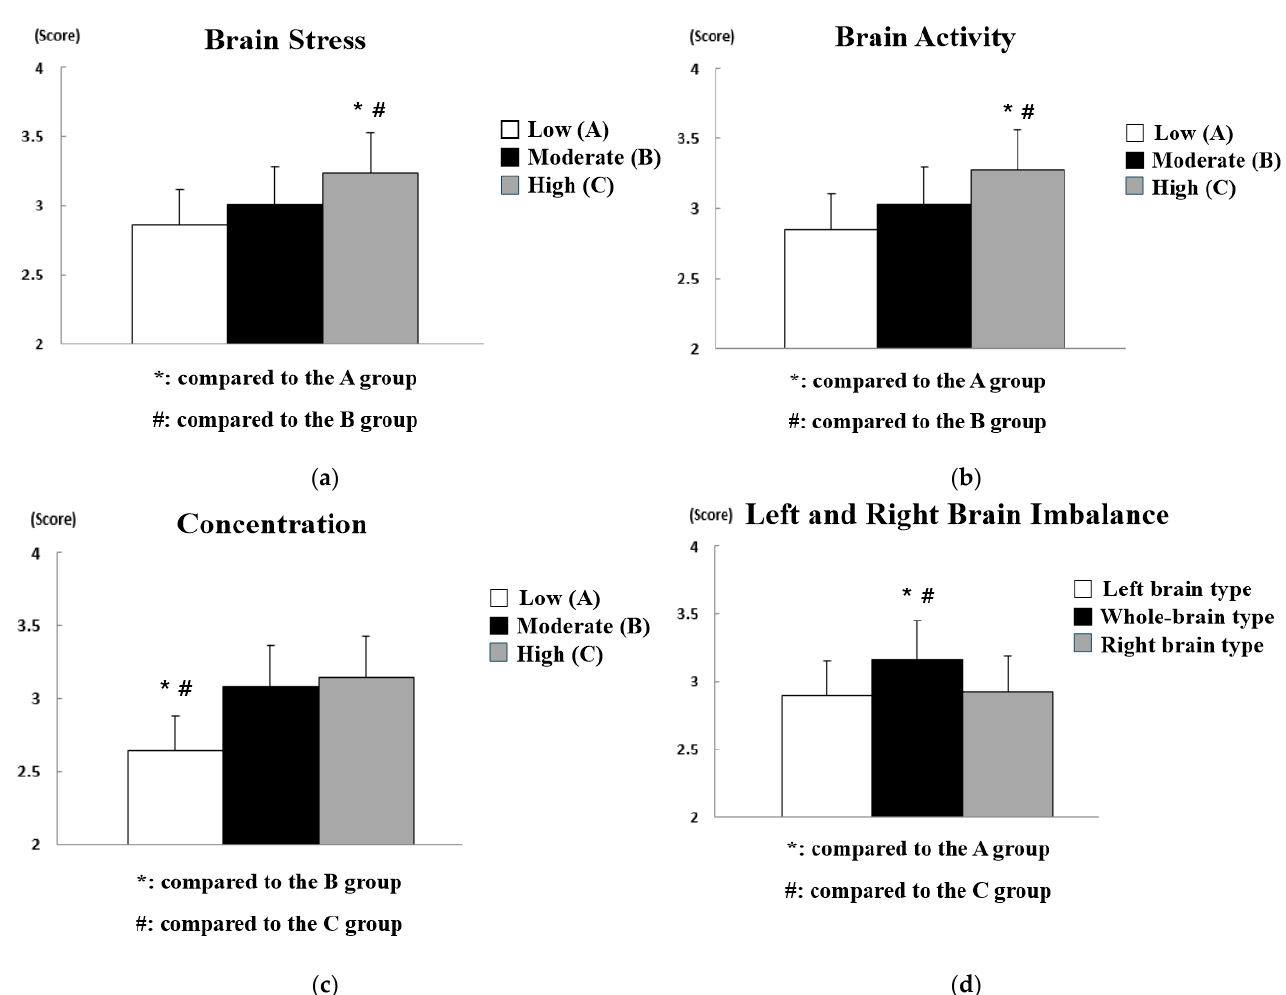
Figure 7. Analysis of differences in safety commitment according to brain wave data: ( a ) effect of brain stress; ( b ) effect of brain activity; ( c ) effect of concentration; ( d ) effect of left and right brain imbalance. Table 6. Statistical analysis results for differences in safety commitment according to brain wave data.